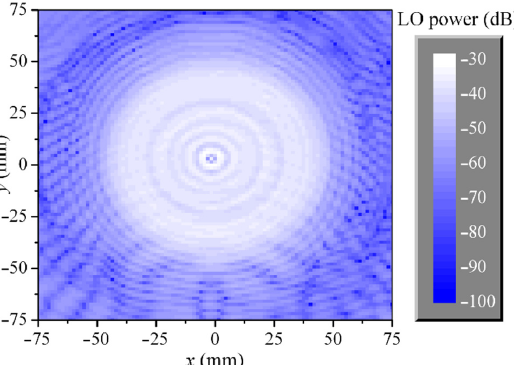
Figure 11. An LO power distribution at the focal plane (a view from the receiver side). In this experimental data, the LO power is the power measured with a probe antenna at the focal plane in relation to power fed to the dielectric rod